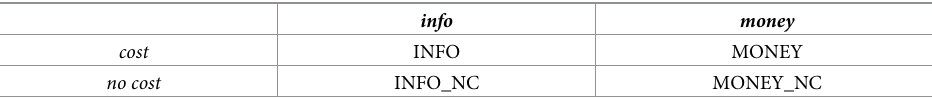
Table 1. Treatments.